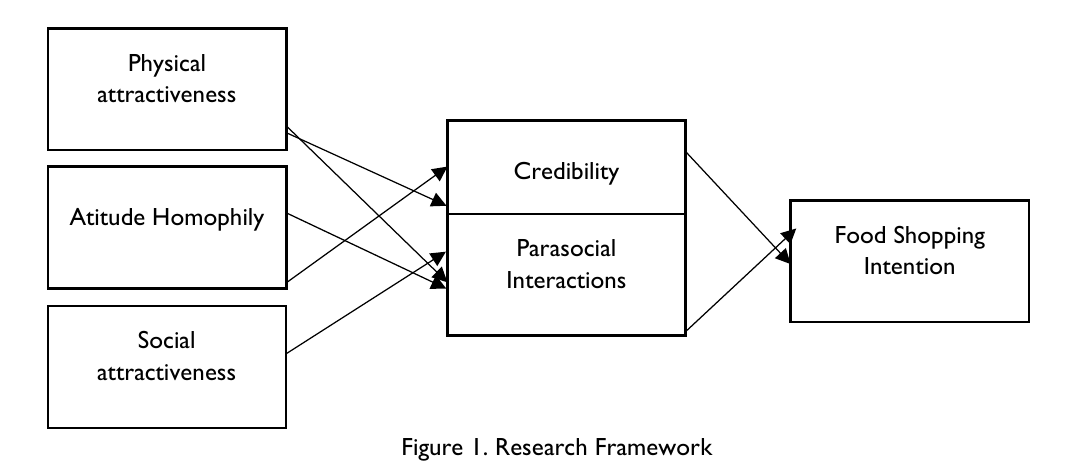
Figure 1. Research